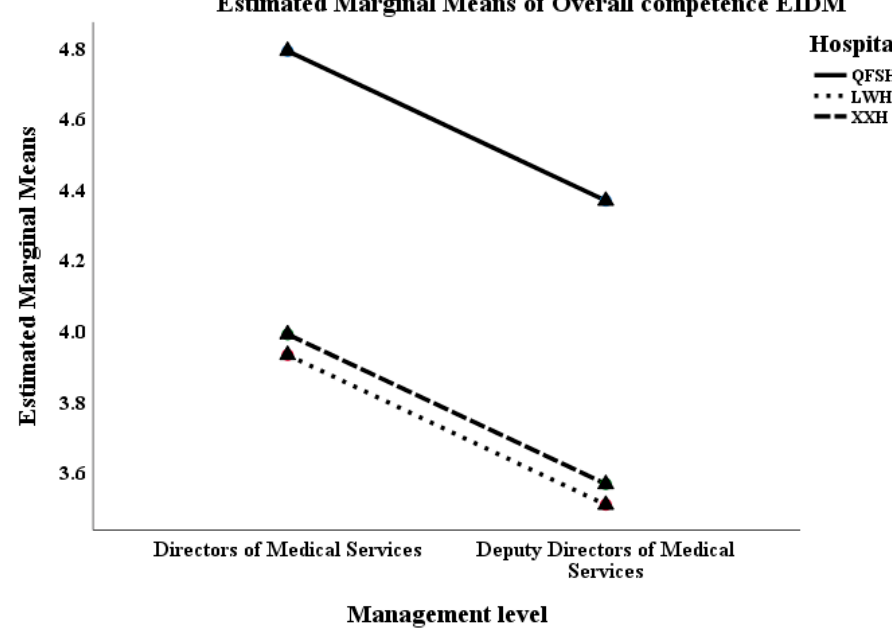
Figure 2. Marginal means for competency 1 (EIDM) by management level and hospital. Level 1—Xi Xian Hospital (XXH); Level 2—Lai Wu Hospital (LWH); Level 3—Qian FoShan Hospital